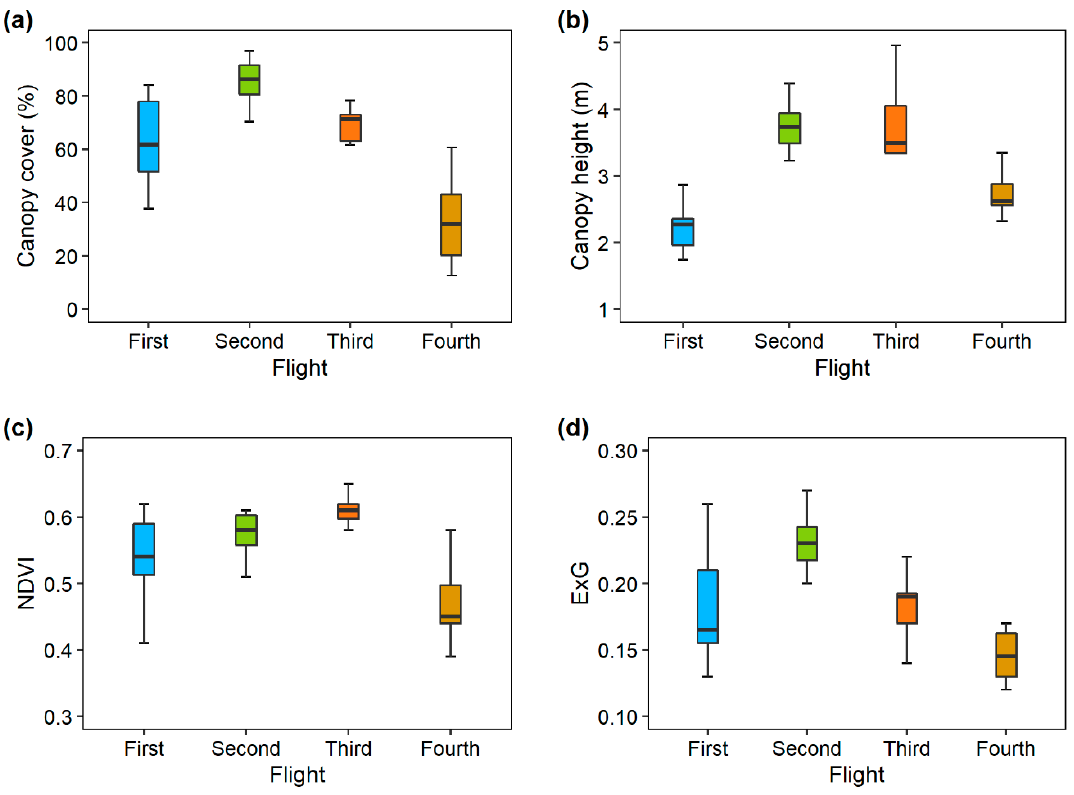
Figure 2. Box-plot of canopy cover ( a ), canopy height ( b ), NDVI ( c ), and ExG ( d ).